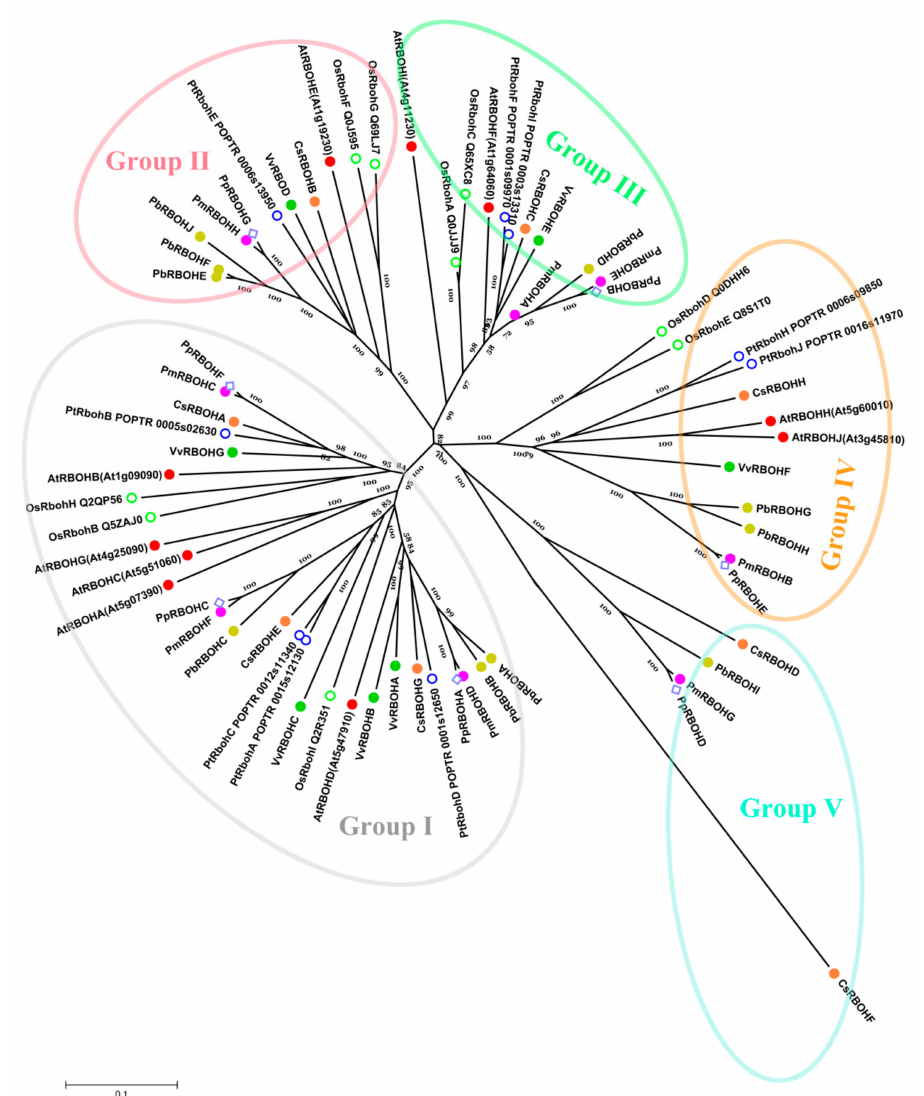
Figure 6. Phylogenetic analysis of RBOHs from five fruit-producing trees (pear, sweet orange, mei, peach and grape) and other known RBOHs. Full-length polypeptide sequences were used to make the interspecific phylogenetic